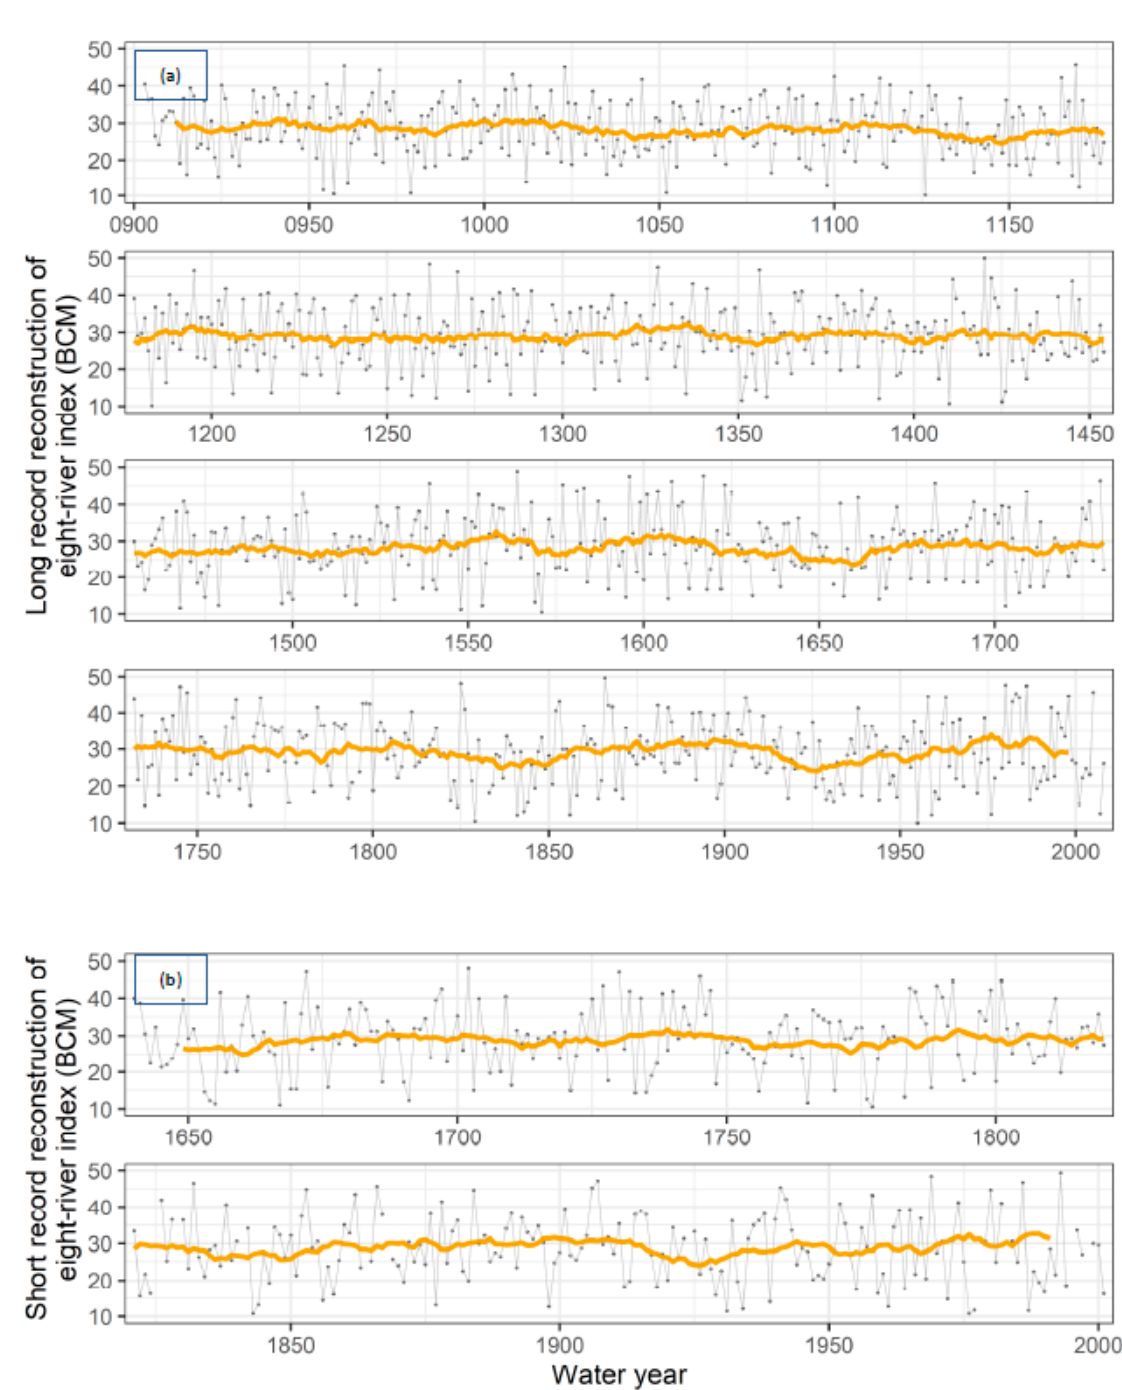
Figure 4. Time series plots of long and short tree-ring reconstructions of Central Valley runoff (Model 1) for ( a ) long record reconstruction, spanning 903–2008 and ( b ) short record reconstruction, spanning 1640–2001. Smooth lines represent 20-year average flows. Other averaging periods, as summarized in Table 4, are excluded from the figure for clarity.